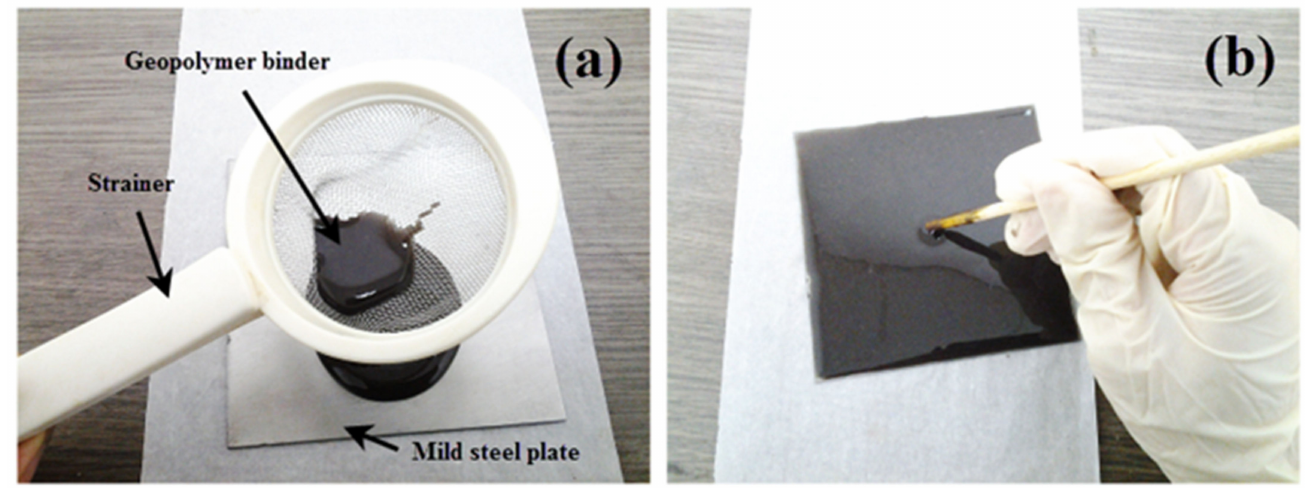
Figure 4. ( a ) Straining and ( b ) spreading the geopolymer